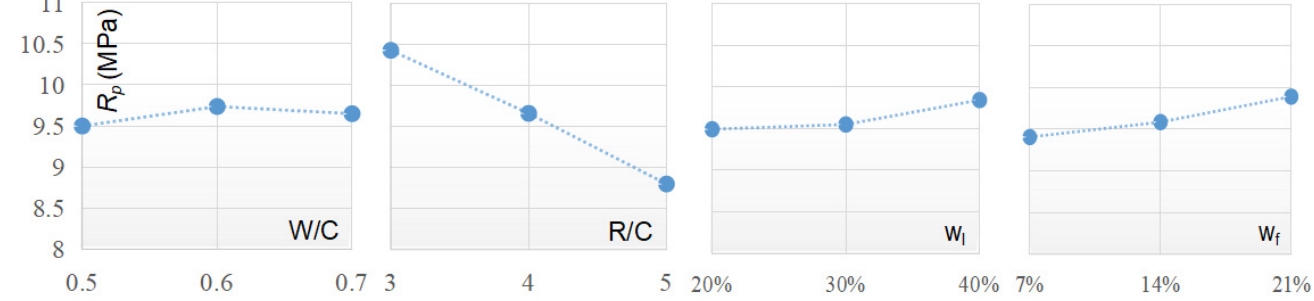
Figure 7. Intuitive analysis of the compressive strength of four factors.